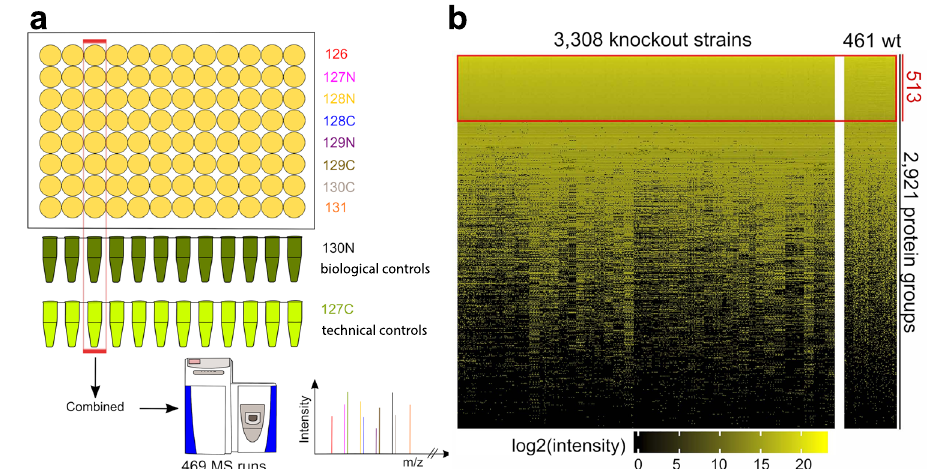
Fig. 1 | Proteomics screentostudy proteomeexpression in a knockout library. a Schematics of the experimental design for quantifying protein expression levels in the S. pombe knockout collection by quantitative proteomicsusing 10plex TMT. Each MS run contained a technical (127C label) and a biological control (130N label), while the biological control samples were grown along with the knockout